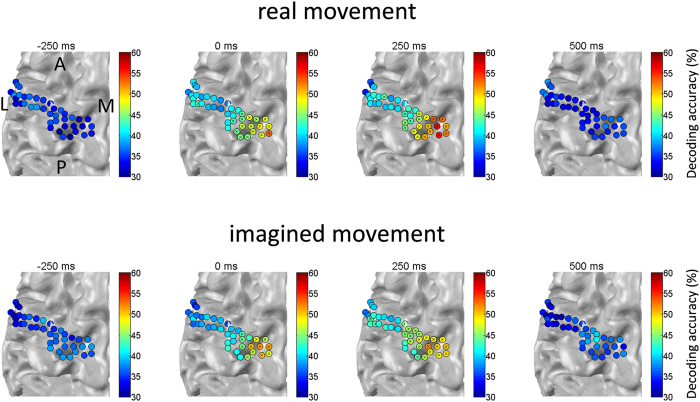
Spatial distribution of decoding accuracies averaged over subjects.Significant decoding accuracies were observed after response onset at the medial part of cM1, particularly around hand and arm areas, during both real and imagined movements. Decoding accuracy was plotted for the first sample acquired in the time window. Virtual channels with significant accuracies are marked with an “x” (binomial test, p < 0.01). A, anterior; L, lateral; M, medial; P, posterior.